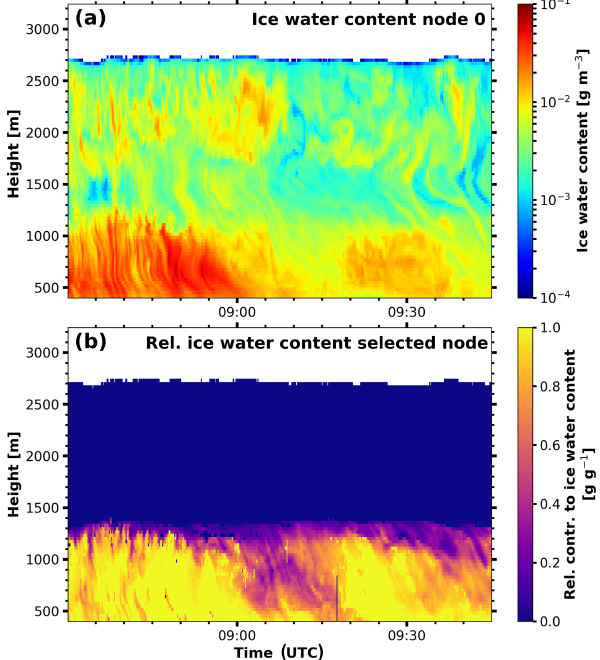
Figure 9. Retrieved ice water content from node 0 (a) and the rel- ative contribution of the particle population with high LDR (b) on 29 June 2017 from 08:30 to 09:45UTC.